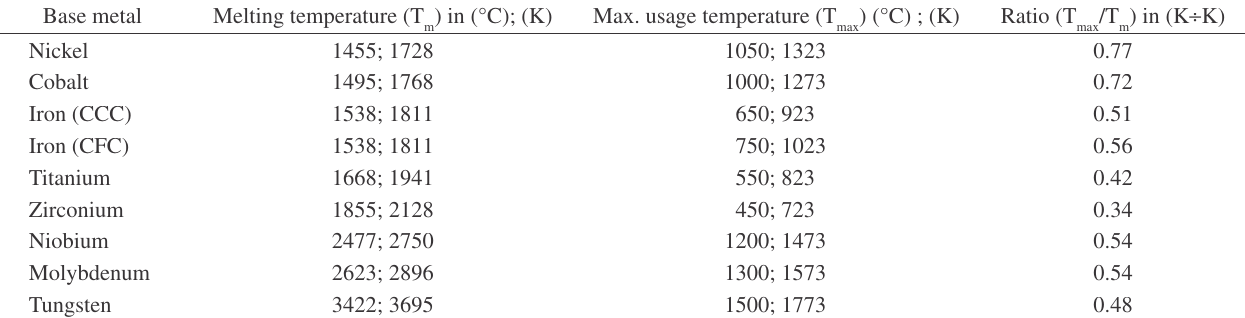
Table 3. Main base-metals employed for high temperature applications and associated alloy maximum usage temperatures 37 .